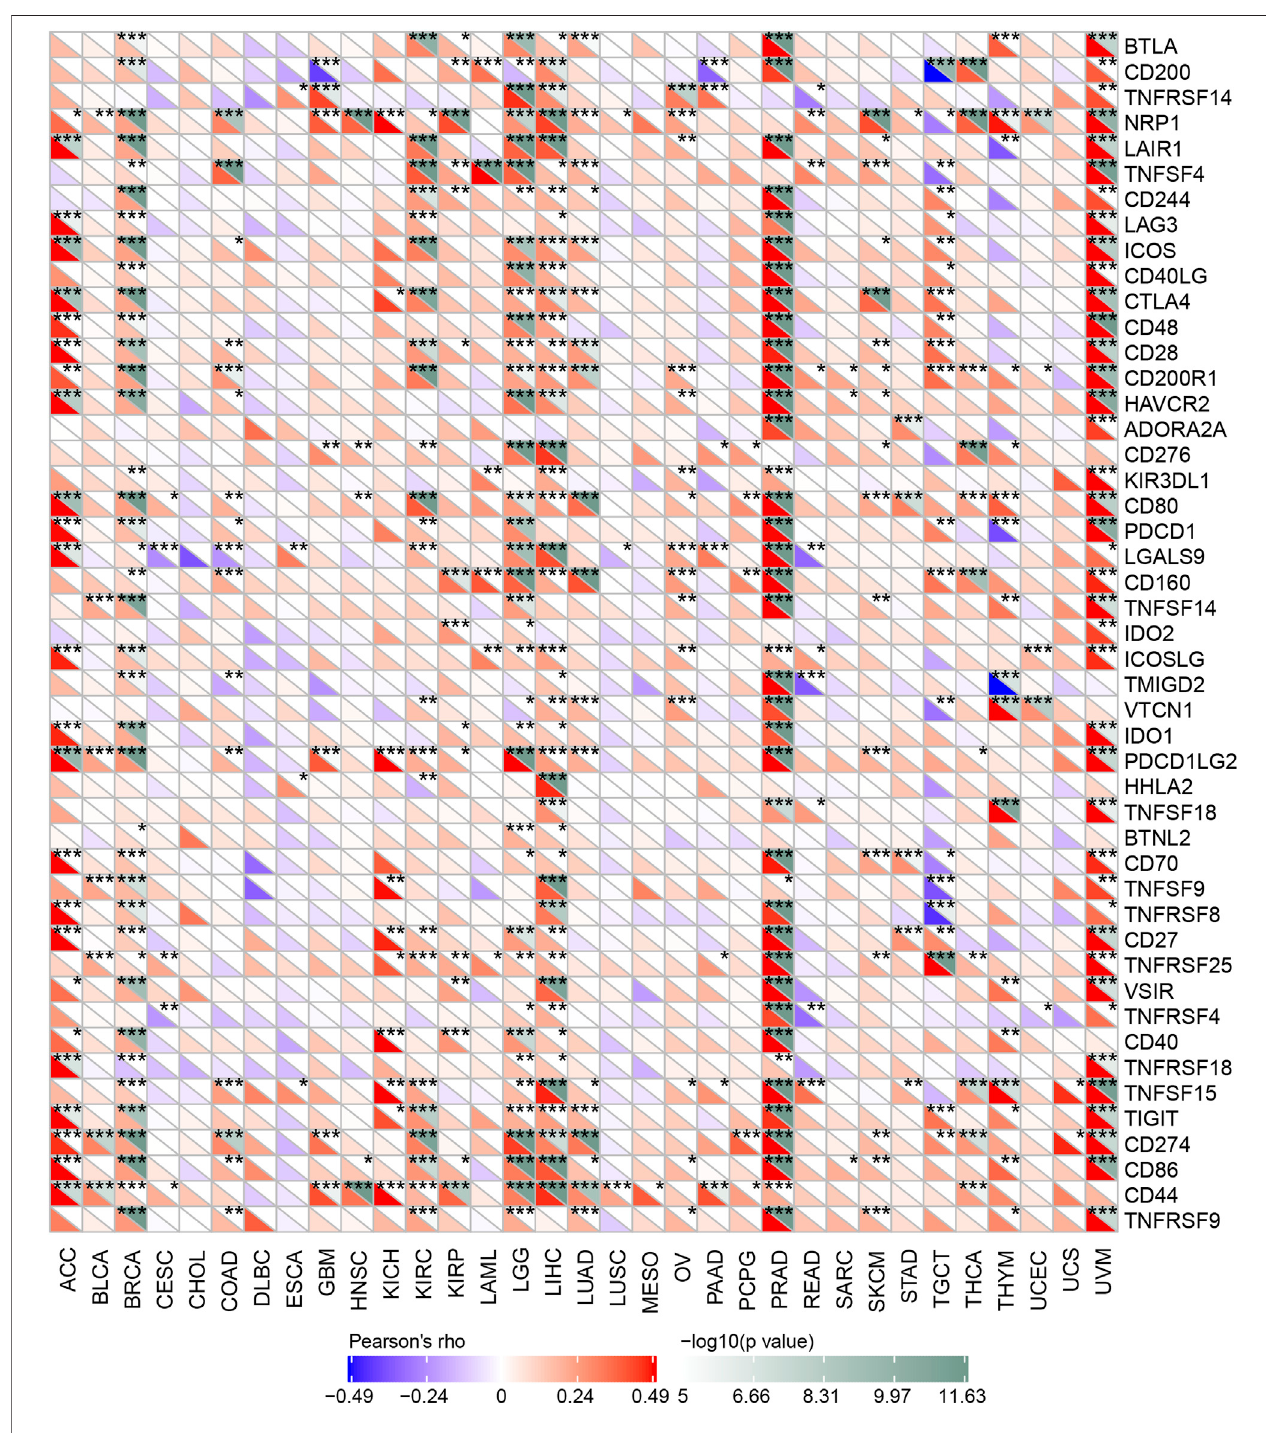
FIGURE 11 | Correlation analysis between OSBPL3 expression and immune checkpoints. Heatmaps of the immune checkpoint – related genes with OSBPL3 expression in different tumor tissues (horizontal axis: different immune checkpoint genes; vertical axis: different tumor tissues. Each box represents the correlation between the expression of the immune checkpoint gene and the OSBPL3 gene in corresponding tumors, and different colors represent changes in correlation coef fi cients. * p < 0.05; ** p < 0.01; *** p < 0.001).